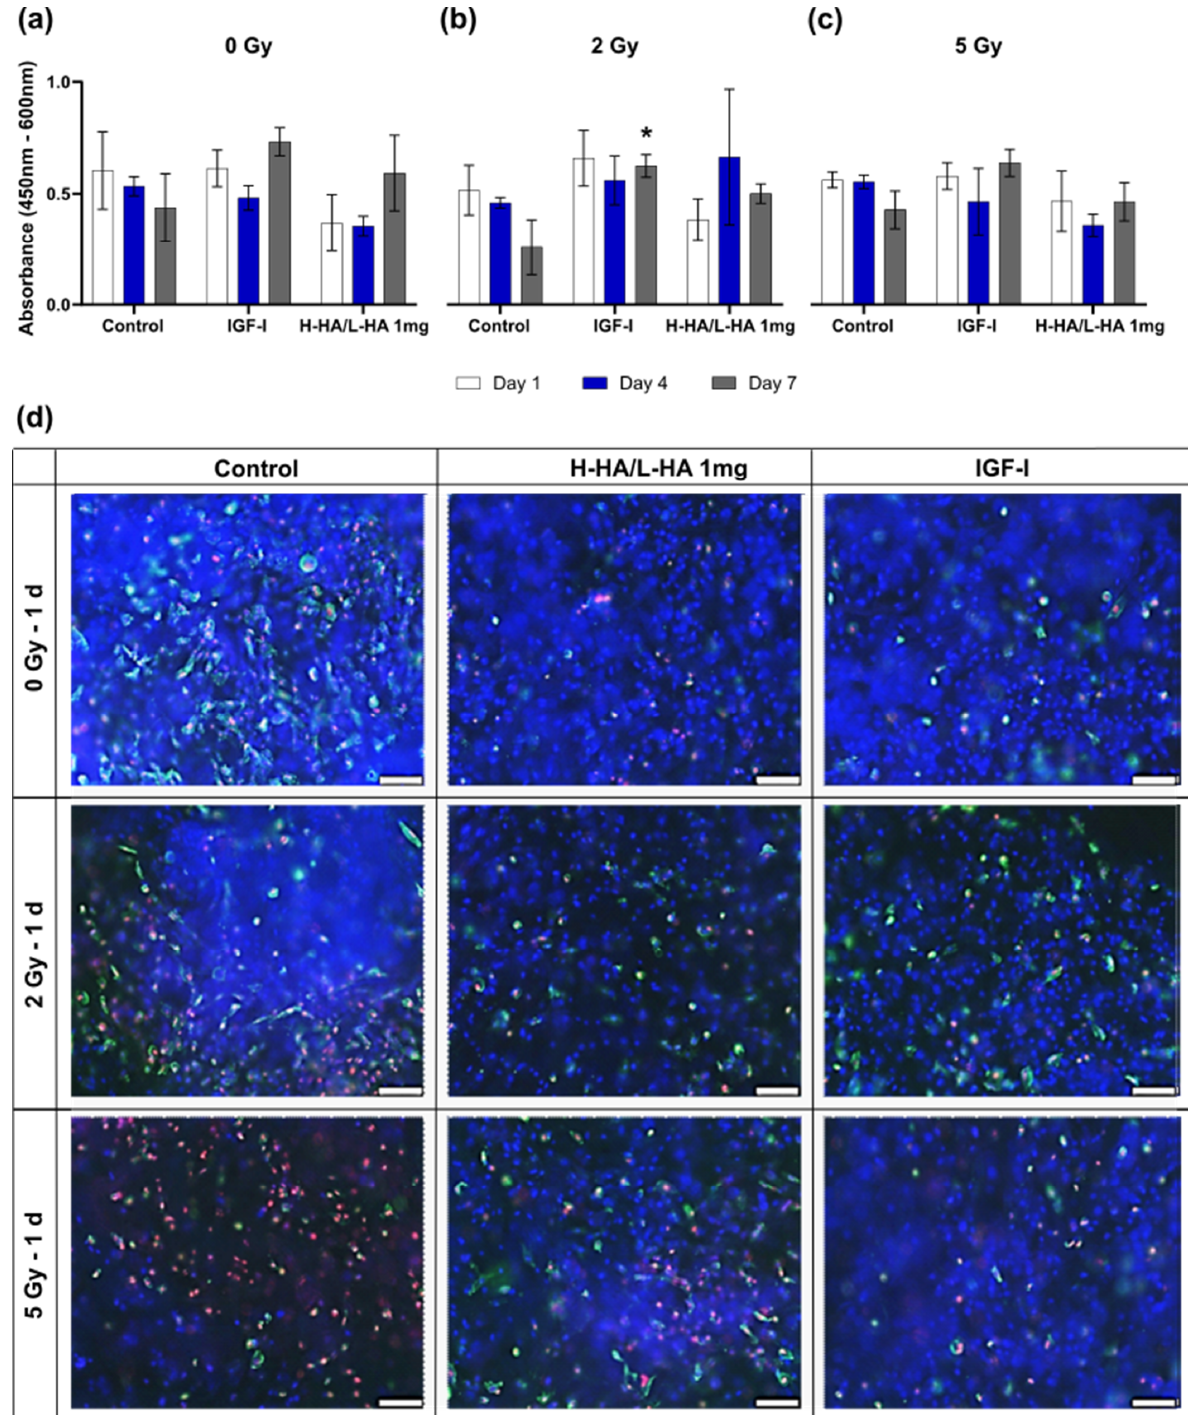
Figure 6. Keratinocyte viability on 3D MatriDerm ® collagen-elastin scaffolds of the irradiation groups 0, 2, and 5 Gy with 1 mg/mL H-HA/L-HA and 100 ng/mL IGF-I supplementation on 1 d, 4 d, and 7 d: ( a ) cell viability without irradiation; ( b ) cell viability after irradiation with 2 Gy; ( c ) cell viability after irradiation with 5 Gy; ( d ) representative images of irradiated keratinocytes at time point 1 d (living = blue, apoptotic = green, dead = red). * p ≤ 0.05, significances were correlated to the respective control. * = significant compared to the control without growth factors in the respective irradiation dose at the respective time point. Scale bar 100 µm.